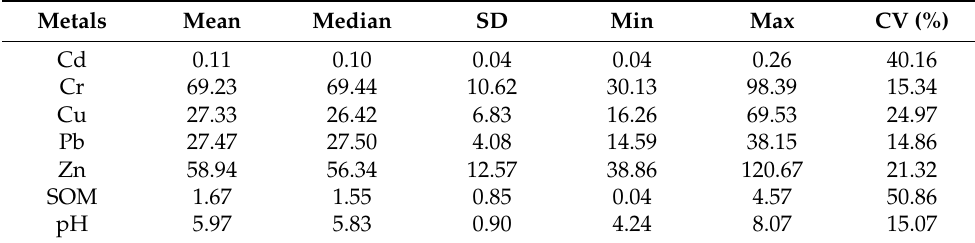
Table 6. Descriptive statistics for heavy metals in the topsoil (mg kg − 1 ; SOM: